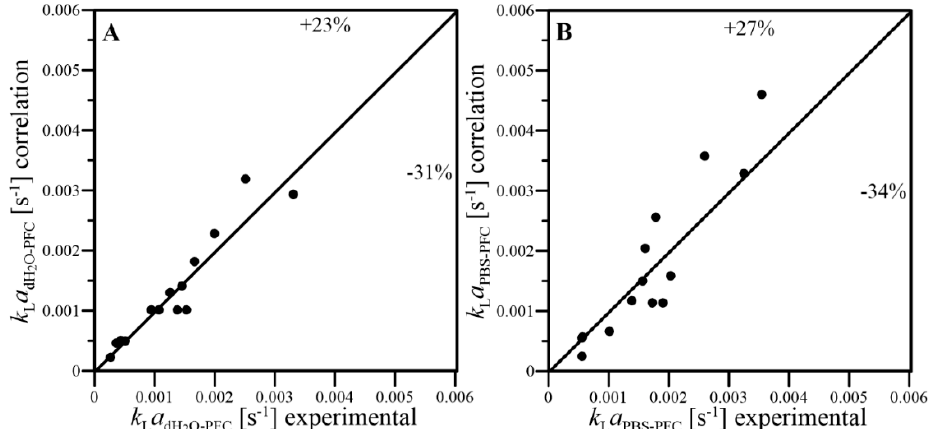
Figure 8. Parity plots of the values of k L a dH correlations (15) and (16), respectively.